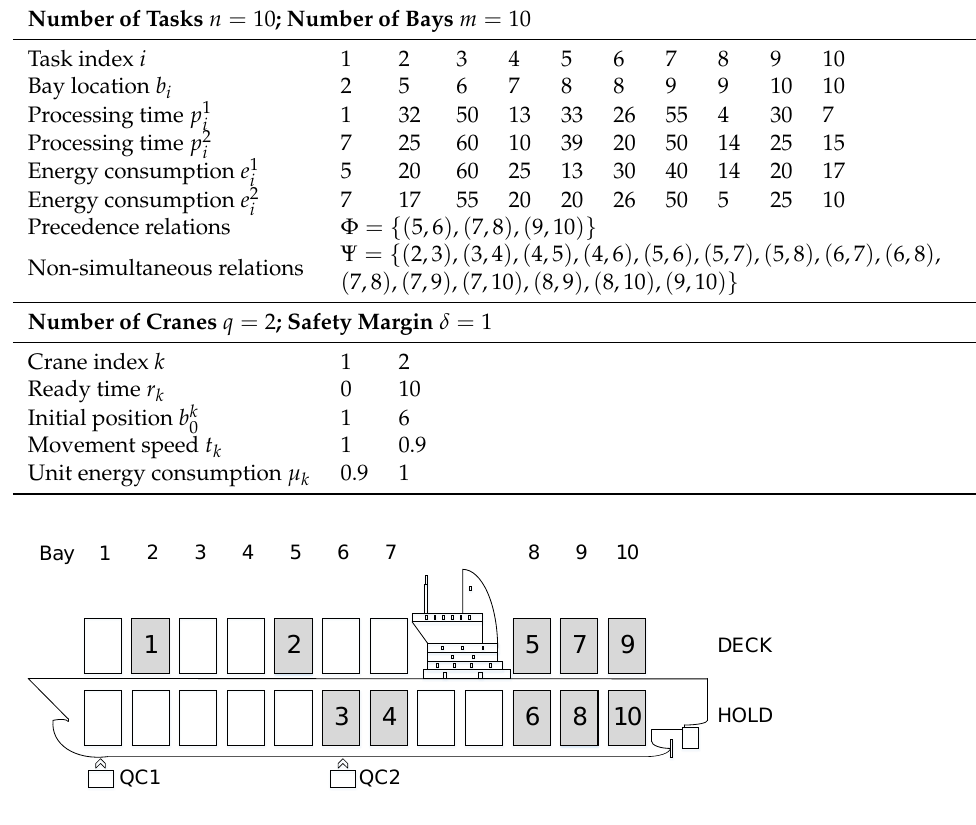
Figure 4. Distribution of quay crane scheduling